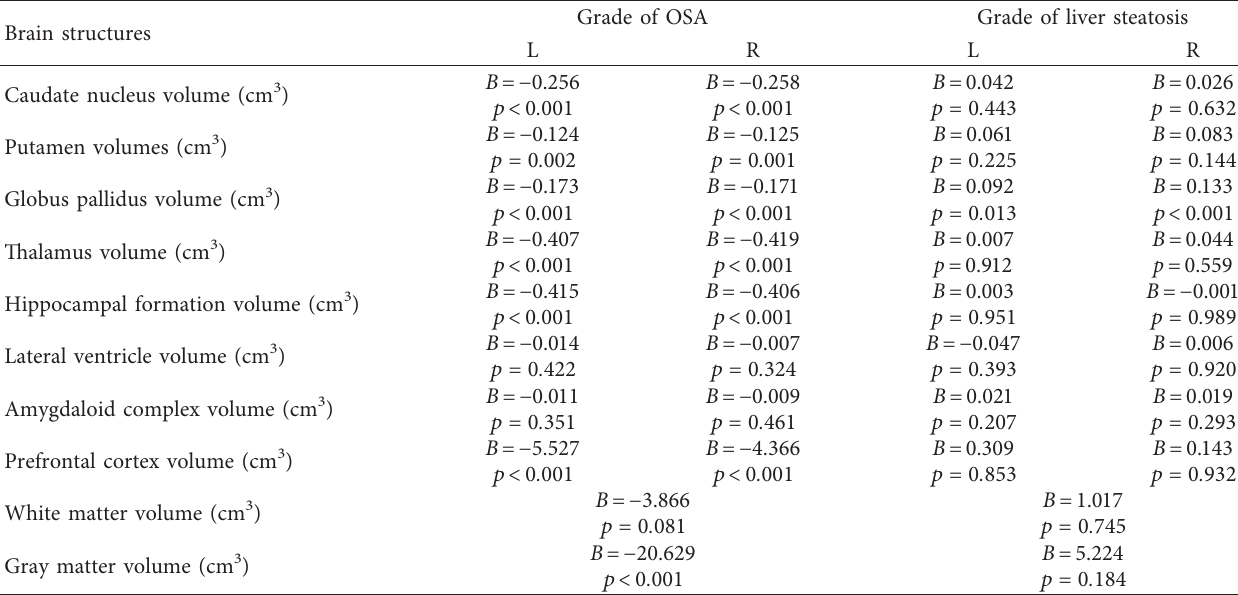
Table 5: Results of the multivariate regression